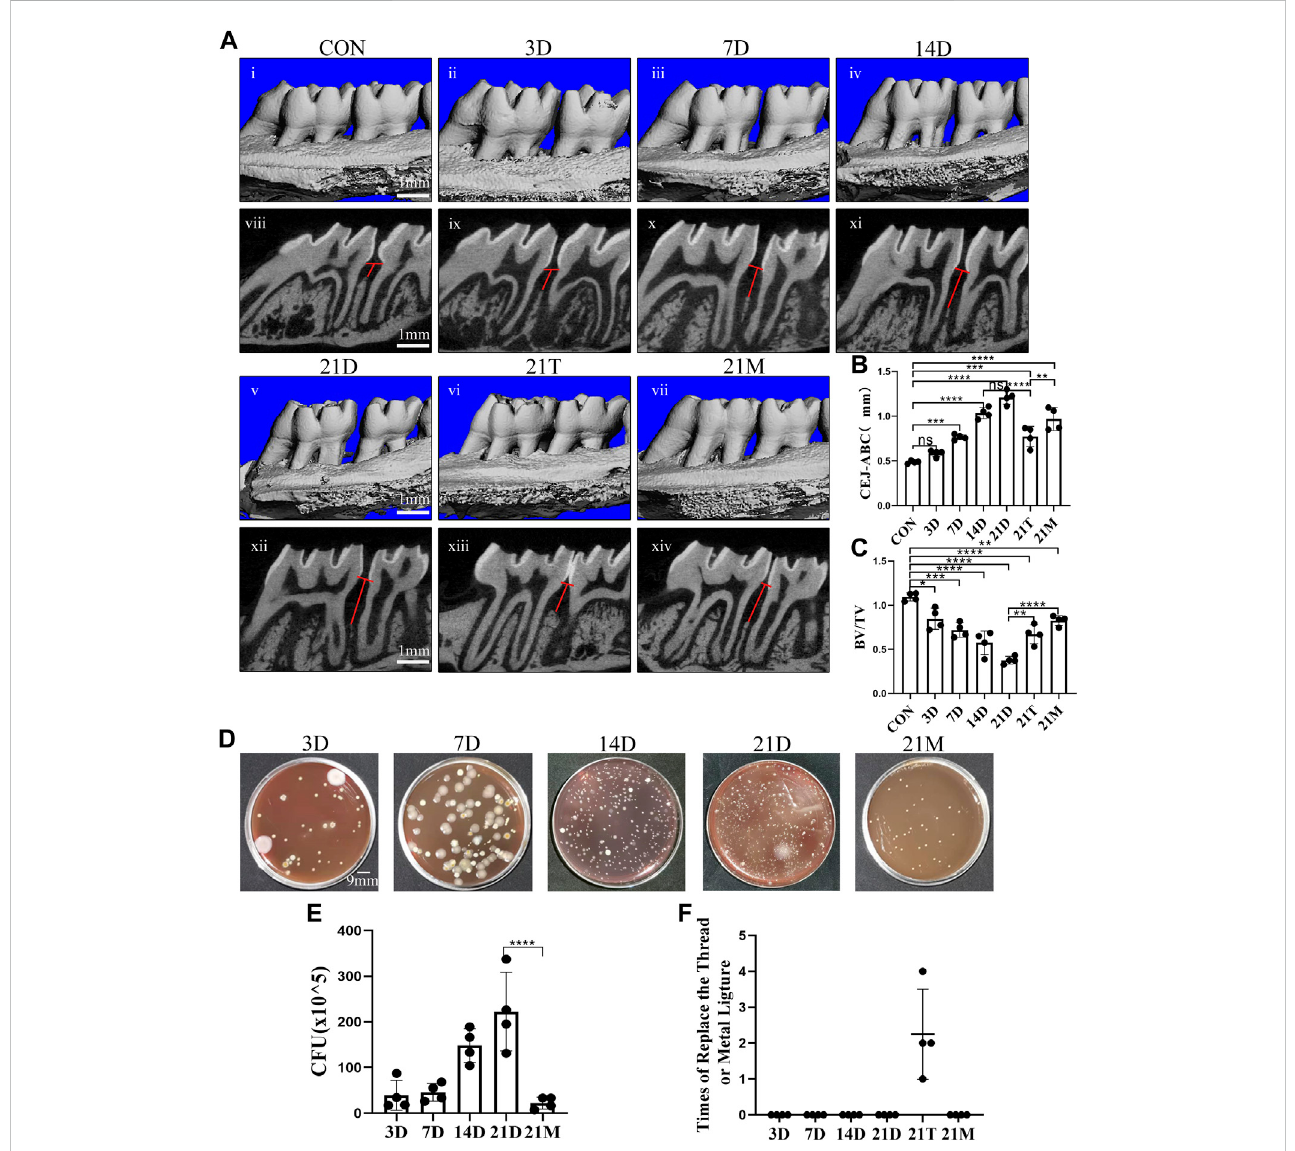
FIGURE 2 Degree of alveolar bone loss and bacteria accumulation after modeling. (A) Representative sagittal 3D (i-vii) and bi-dimensional views (viii-xiv) of the maxillary molars from CT scanning of the correspond groups. The red line corresponds to the distances from the cementoenamel junction to the alveolar bonecrest(CEJ – ABC). (B,C) MeasurementofthedistancefromtheCEJtotheABCandtheratioofbonevolumetotissuevolume(BV/TV)ateachgroupafter modeling. (D) Photographofcolonyformingunit(CFU)fromthe3Dgroup, the7Dgroup,the14Dgroup,the21Dgroupandthe21Mgroup. (E)